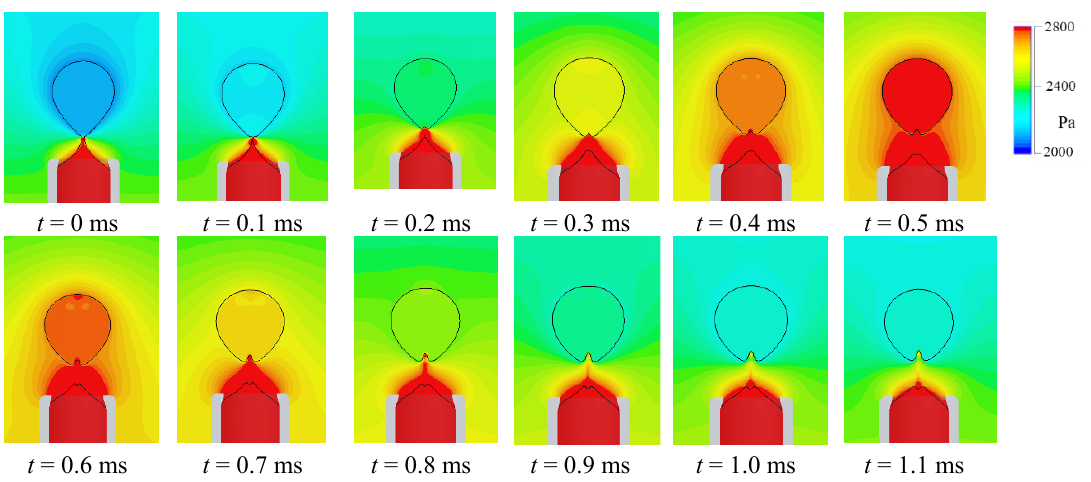
Figure 8. Pressure distribution from the bubble detachment for one cycle for φ = 6 mm.